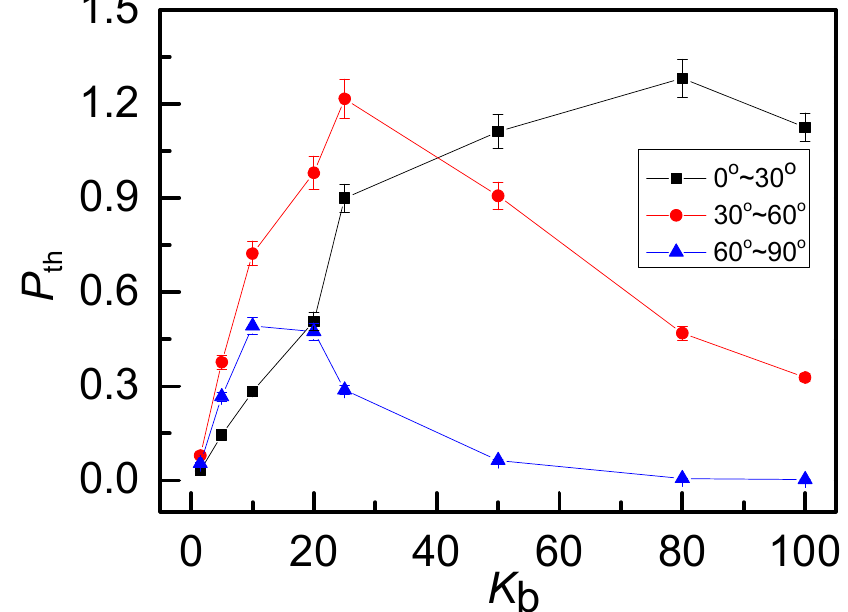
Figure 8. Average threading number P th of 0 1 -knot rings within di ff erent angel ranges as a function of bending energy K b shows a strong anisotropic character. For rigid rings, the penetration of medium and big angles are suppressed due to the parallel